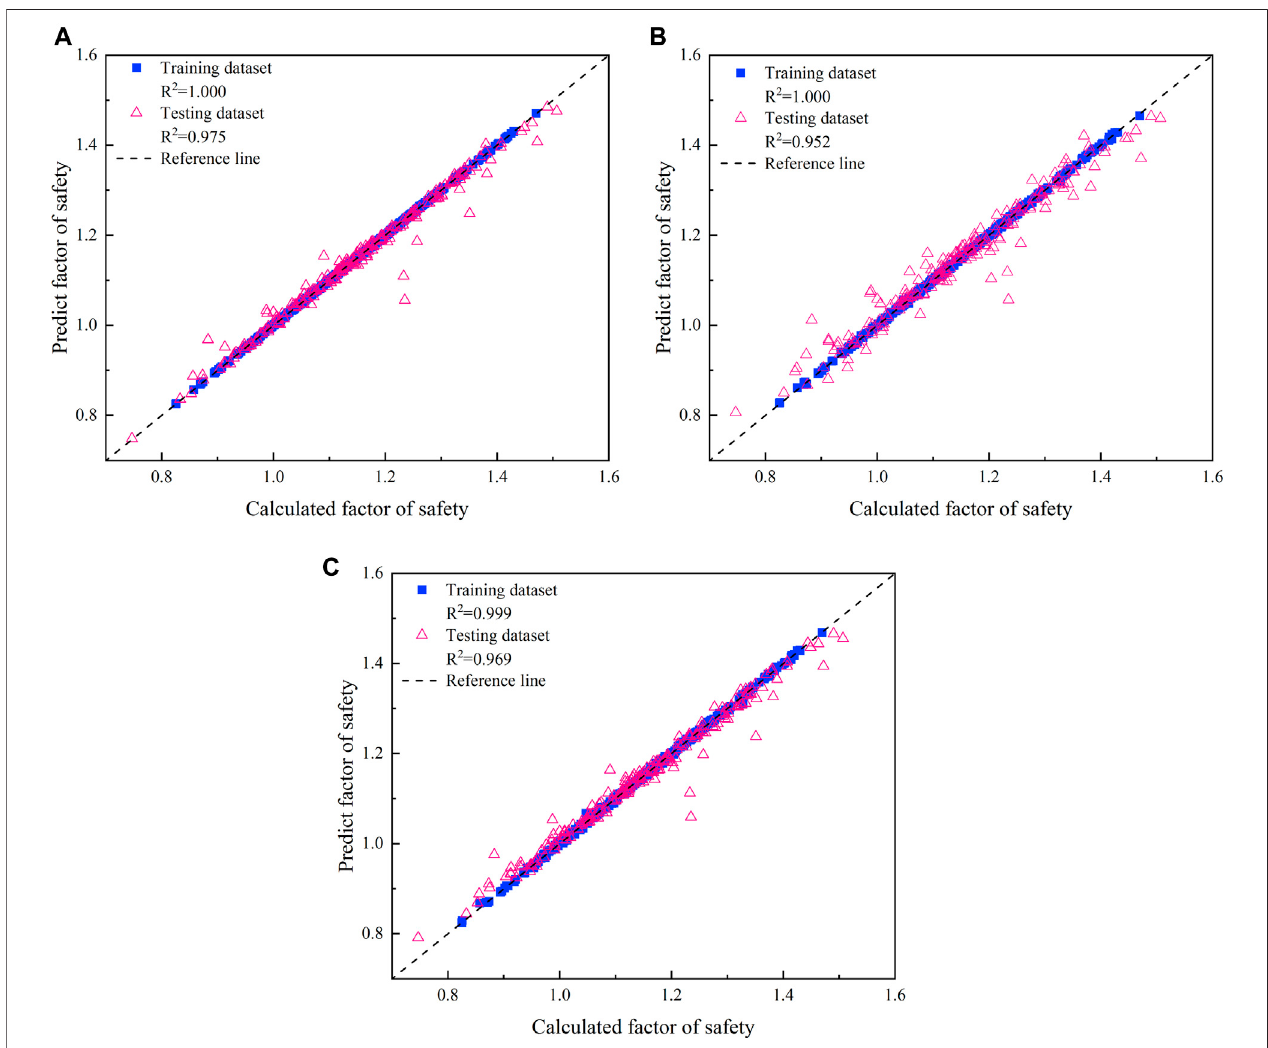
FIGURE 5 | Predictive performance of the three gradient boosting algorithms: (A) CatBoost model; (B) LightGBM model; (C) XGBoost model.